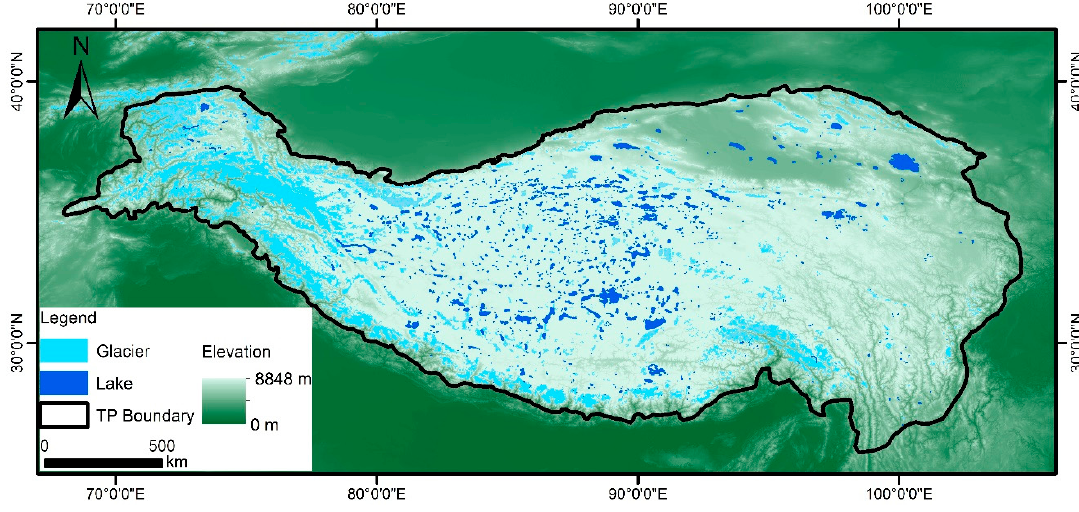
Figure 1. Geographical distribution of lakes and glaciers in the Tibetan Plateau.